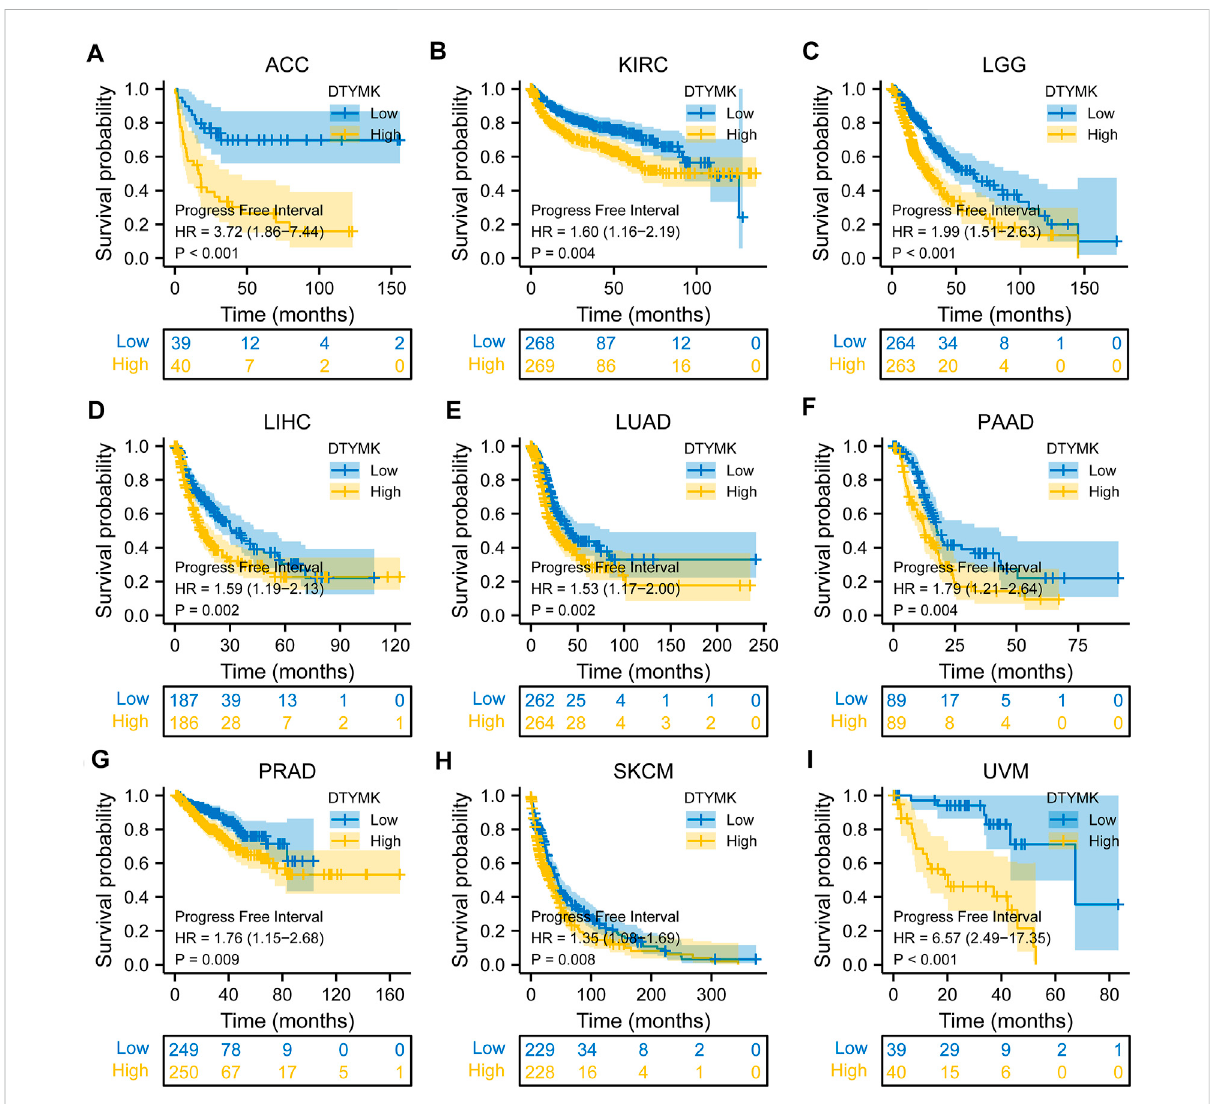
FIGURE 7 Relationship between DTYMK expression and PFI. DTYMK acted as a risk factor for patients with ACC (A) , KIRC (B) , LGG (C) , LIHC (D) , LUAD (E) , PAAD (F) , PRAD (G) , SKCM (H) , and UVM (I)